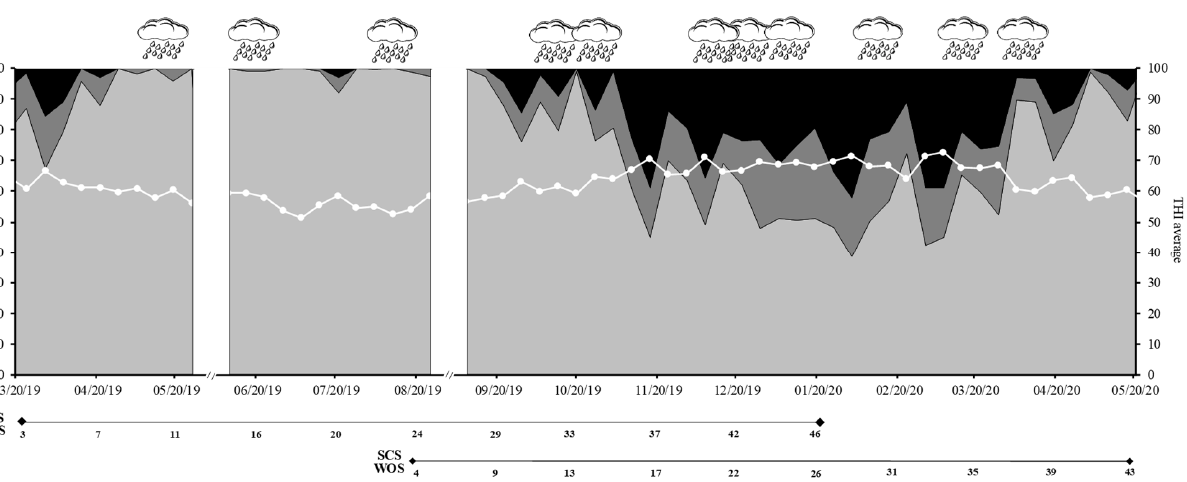
Table 3. Total mixed ration (TMR) and pasture dry matter intake (DMI) per cow (kg DM/day) in the autumn and spring calving seasons in confined (CB ‐ TMR) and mixed systems with low (CB ‐ GRZ) or high (OD ‐ GRZ) environmental exposure during complete lactation.